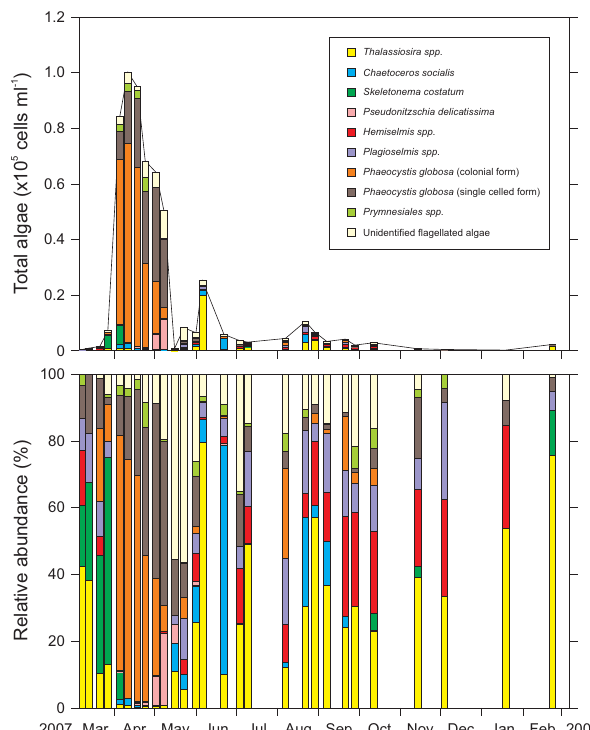
Fig. 3. Abundances of the different algal groups in the Marsdiep. The upper graph shows the absolute abundances, while the lower graph shows relative abundances (normalized to the total